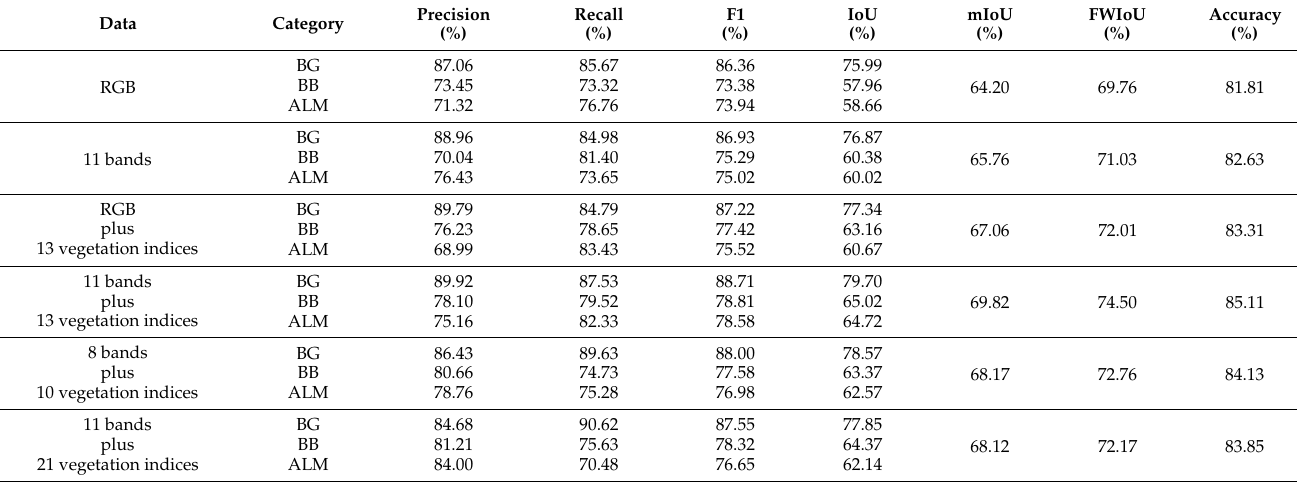
Table 7. Effect of different data on the segmentation result of infested areas using